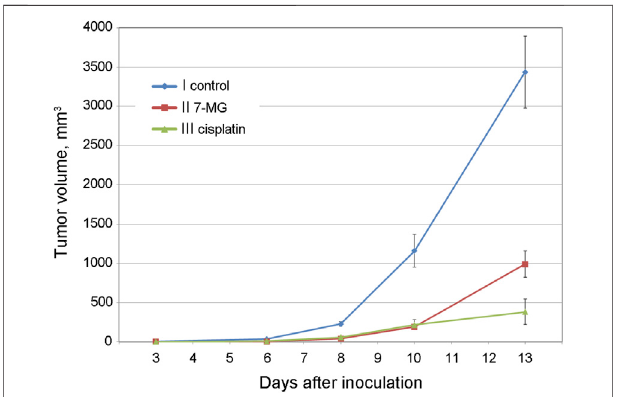
FIGURE 4 | Dynamics of RShM-5 tumor growth in female CBA mice at different treatment regimens. *7-MG was given for 1 week